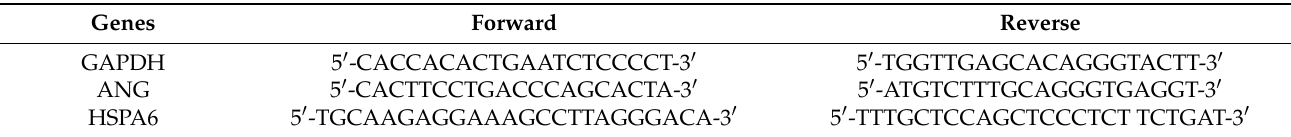
Table 2. Primer sequences associated to selected